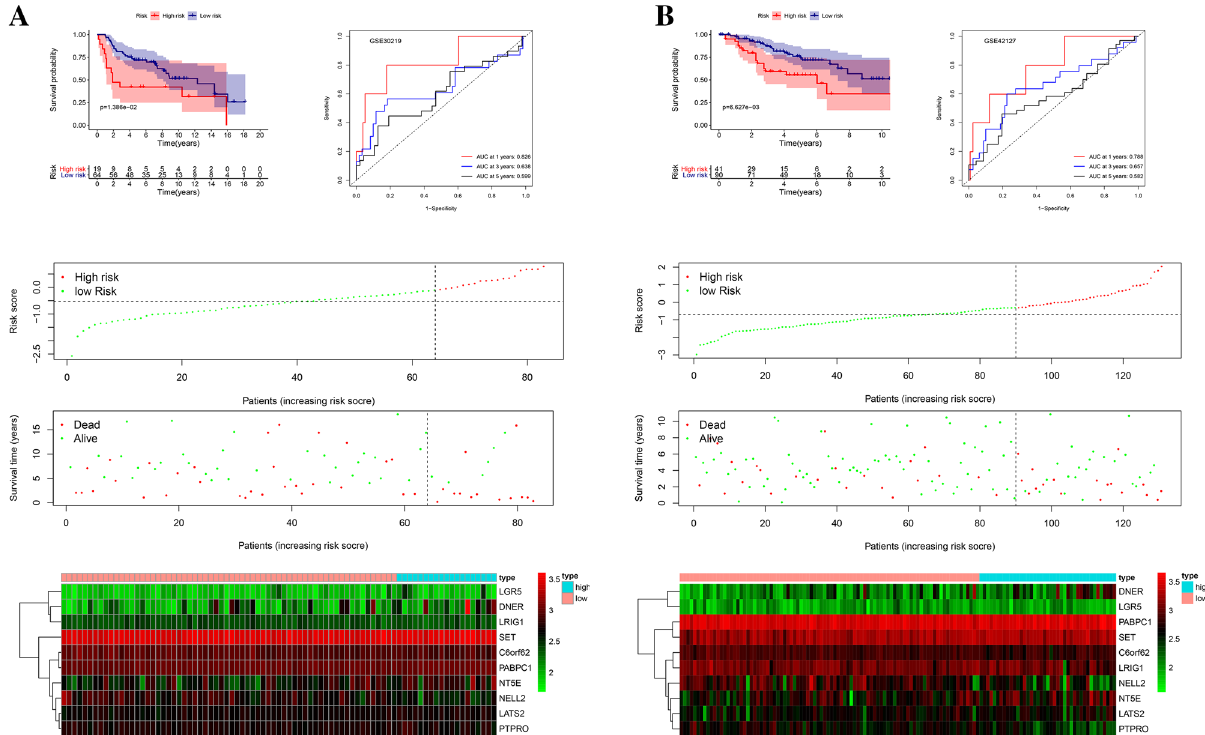
Figure 2. Validation of the signature in GEO. ( A ) Kaplan–Meier survival, ROC curve, and risk plot were used to verify the signature in the GSE30219. ( B ) Kaplan–Meier survival, ROC curve, and risk plot were used to validate the signature in the